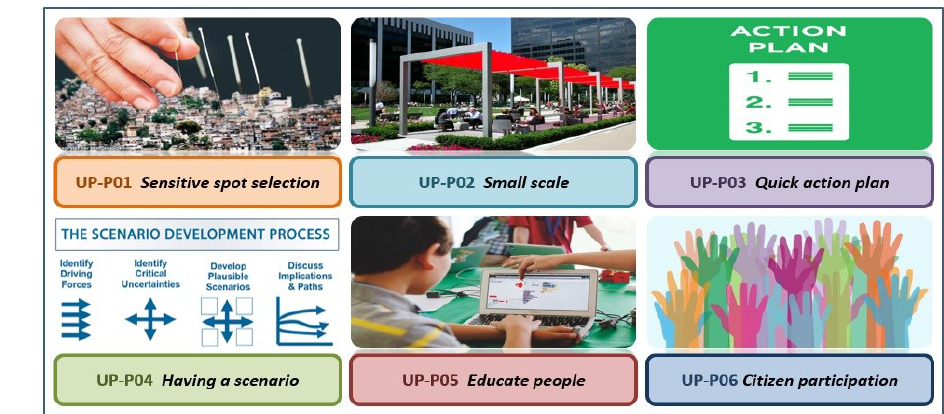
Figure 2. Urban Acupuncture